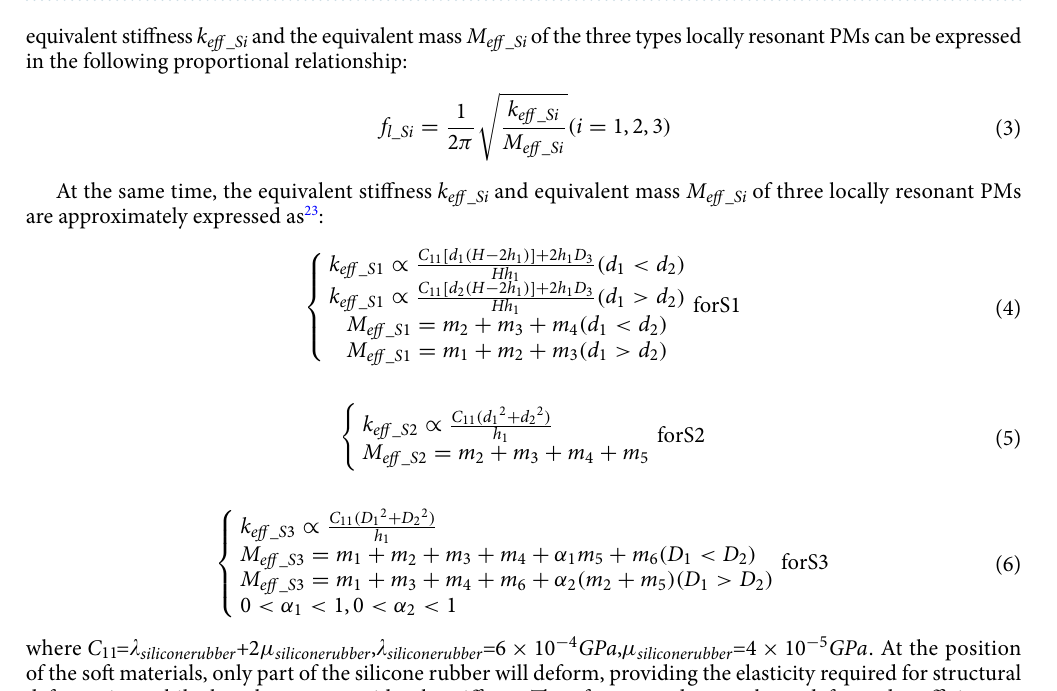
Figure 3. The model diagram of the “spring mass” system of the ( a ) S1, ( b ) S2 and ( c ) S3,